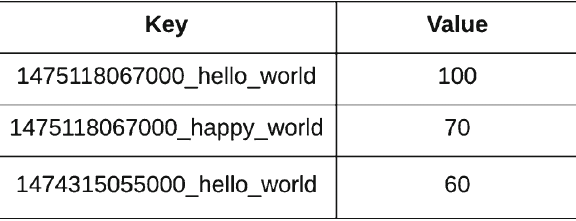
Fig. 5 Redis result structure